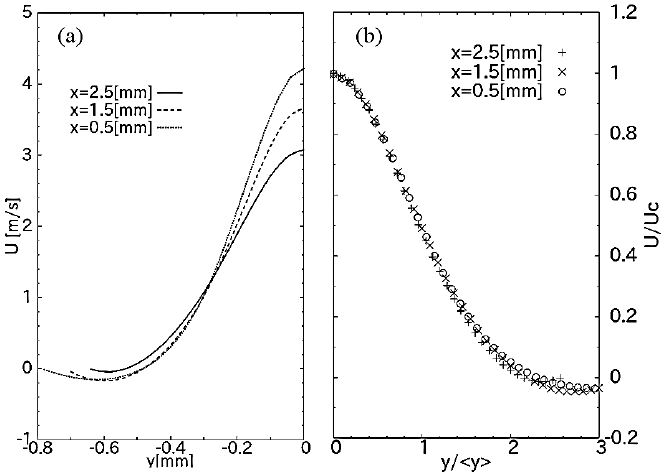
Figure 4. Transient characteristic of the flow in the working chamber with different amplitudes of the diaphragm. The flow is monitored at 2.5 mm downstream from the nozzle. The amplitudes of the diaphragm are 5 μ m, 7.5 μ m, and 10 μ m.